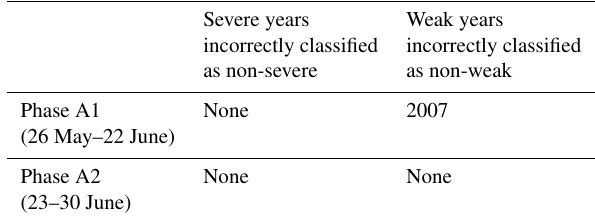
Table 1. Performance assessment of Type A decisions during the pre-fire season (26 May to 30 June) based on the model with two